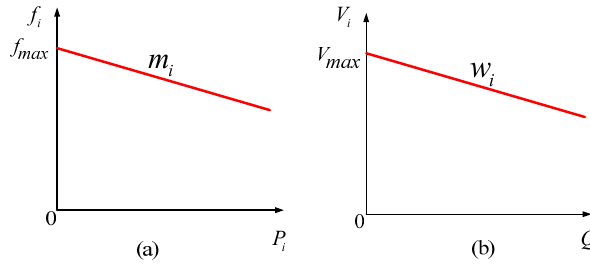
Figure 1. Traditional droop scheme: ( a ) P-f characteristic; and ( b ) Q-V characteristic.